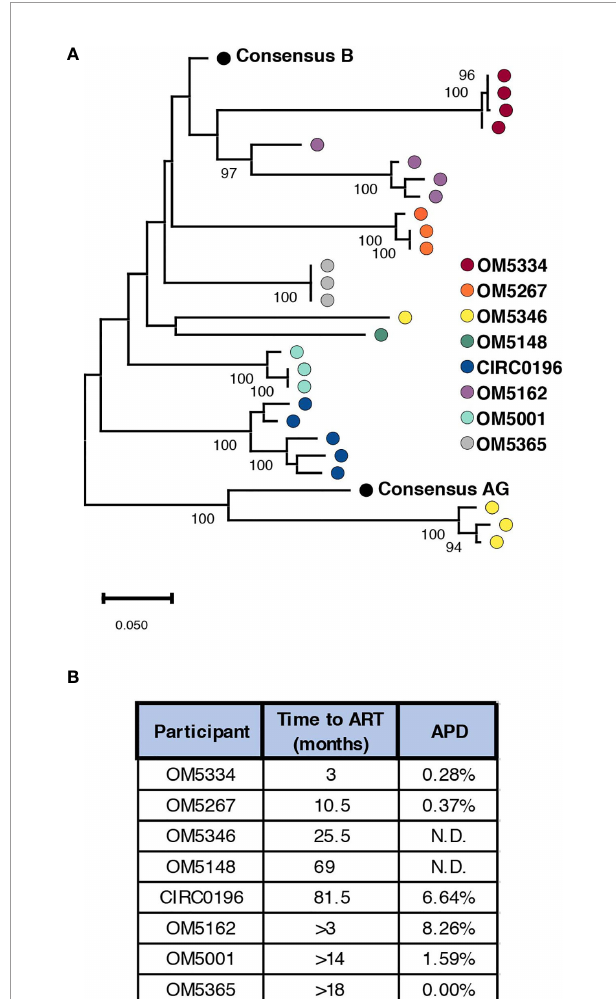
FIGURE 1 | Genetic diversity of participant reservoir virus increases with active infection length. (A) A minimum of 3 SGS sequences were used to generate consensus sequences for each QVOA well. The protein sequence of each well was aligned to consensus subtype B and AG and a maximum likelihood tree was generated. Wells containing multiple viruses were excluded. Each dot represents one QVOA outgrowth virus well and is color-coded by participant. The tree is midpoint rooted for visualization and bootstraps over 90% are shown. (B) For all participants a minimum duration of infection was calculated using the date of diagnosis and date of ART initiation. For individuals for whom an HIV - date was con fi rmed, an estimated length of infection was calculated using an estimated date of infection as the midpoint between con fi rmed HIV - and HIV + time points. For each person, these estimated times of active infection are listed next to the average pairwise distance (APD) of Env for their inducible reservoir